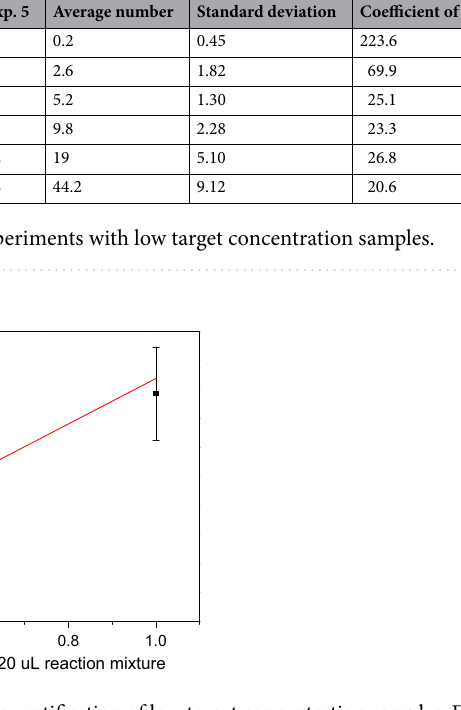
Figure 8. Positive droplet counting based quantification of low target concentration samples. Error bars are standard